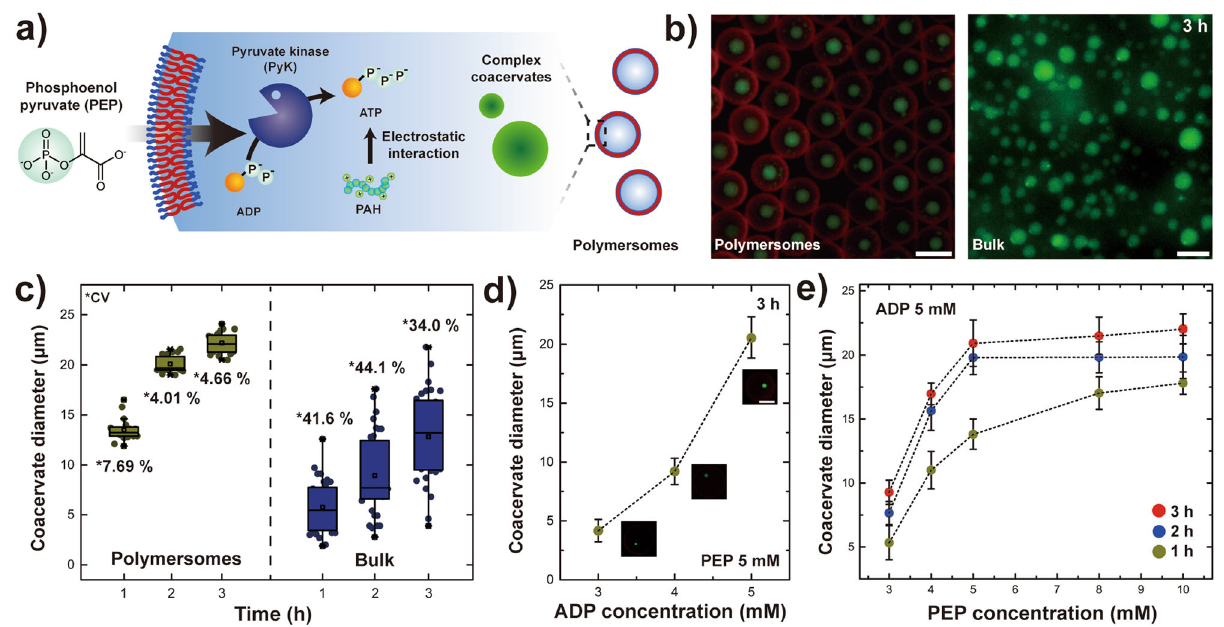
Fig. 3 | Signal-driven complex coacervation in polymersomes. a Schematic illustration of the enzymatic reaction-induced complex coacervate formation in polymersomes. b Fluorescence micrographs showing the PEP-driven complex coacervate formation via pyruvate kinase (PyK) enzymatic reaction 3h after PEP infusion in polymersome (left) and in bulk (right). The scale bars each represent 100 µ m (left) and 20 µ m (right), respectively. c Plot showing the change in coa- cervate diameter over time in polymersomes ( n =20) and in bulk ( n =32). All box plotsindicatemedian(middleline),25th,75thpercentile(box)andwhiskersaswell asoutliers(1.5interquartilerangevalue). d Plotshowingthecoacervatediameterin